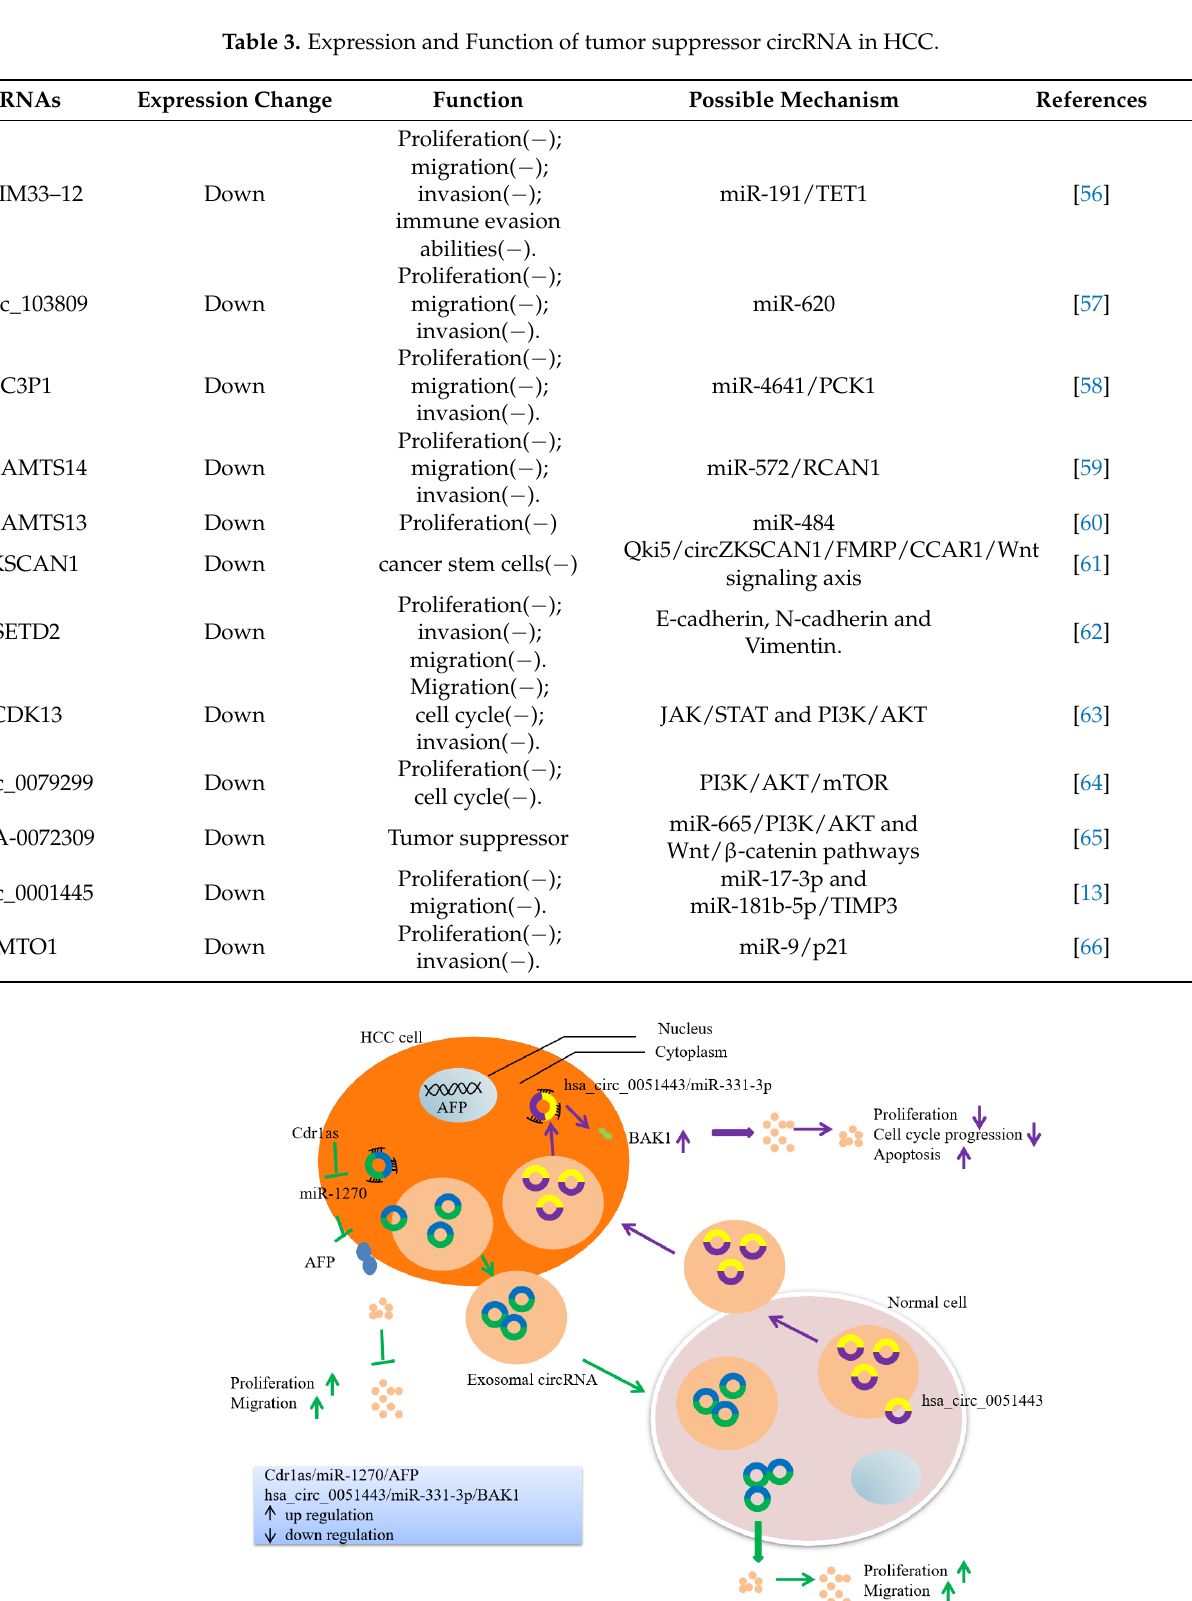
Figure 3. Exosomes transferred from HCC cells to surrounding normal cells or from surrounding normal cells to HCC cells mediate the biological progression of HCC. Exosomal circRNA Cdr1as stimulated malignant behaviors of surrounding normal cells. Exosomal circular RNA hsa_circ_0051443 suppresses the progression of HCC.